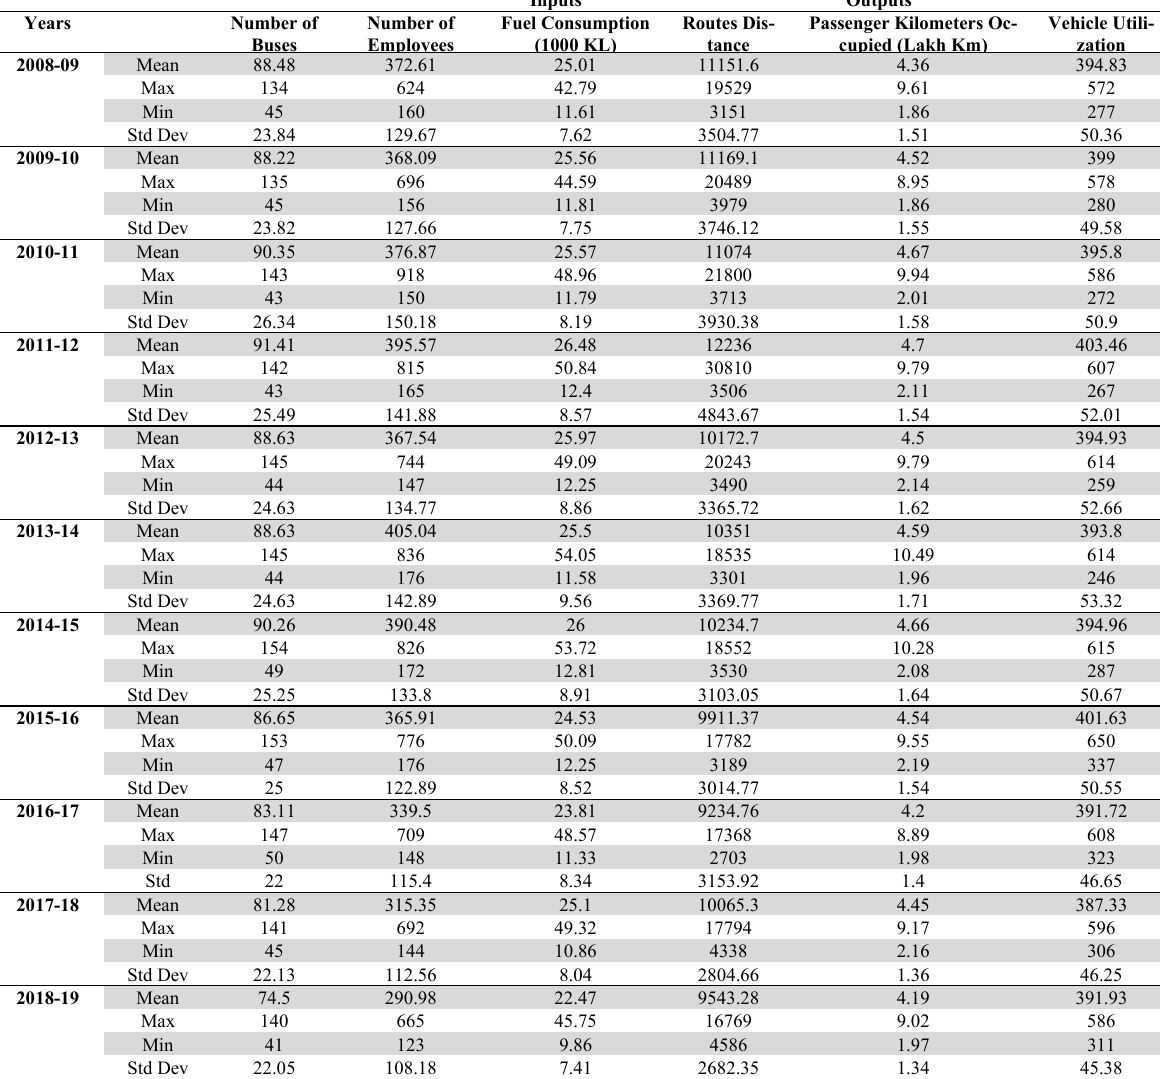
Statistics Summary of RSRTC Depots for the Period